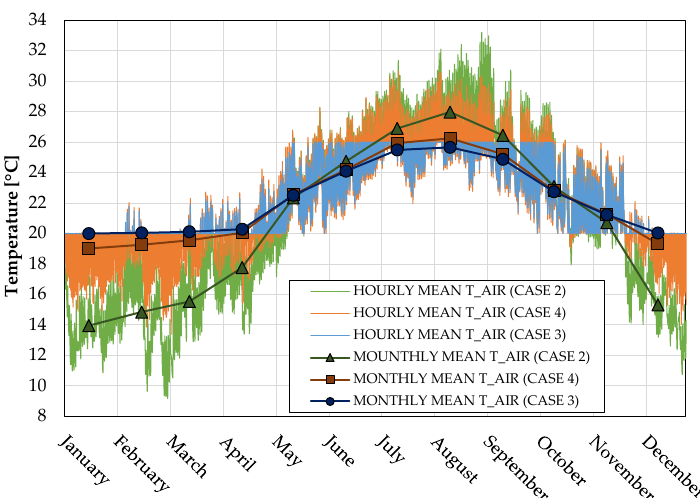
Figure 15. Comparison of average hourly and monthly average indoor air temperatures in the THU among CASES 2, 3 and 4.